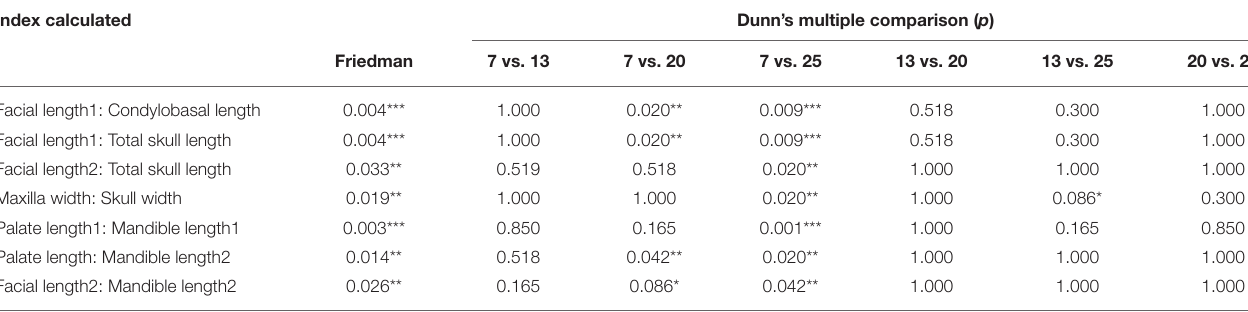
TABLE 6 | Listing of the seven calculated indices for cranium and facial growth in five young growing cheetahs which were significantly different from each other using the Friedman’s test, followed by the significance levels using Dunn’s multiple comparisons test. Index